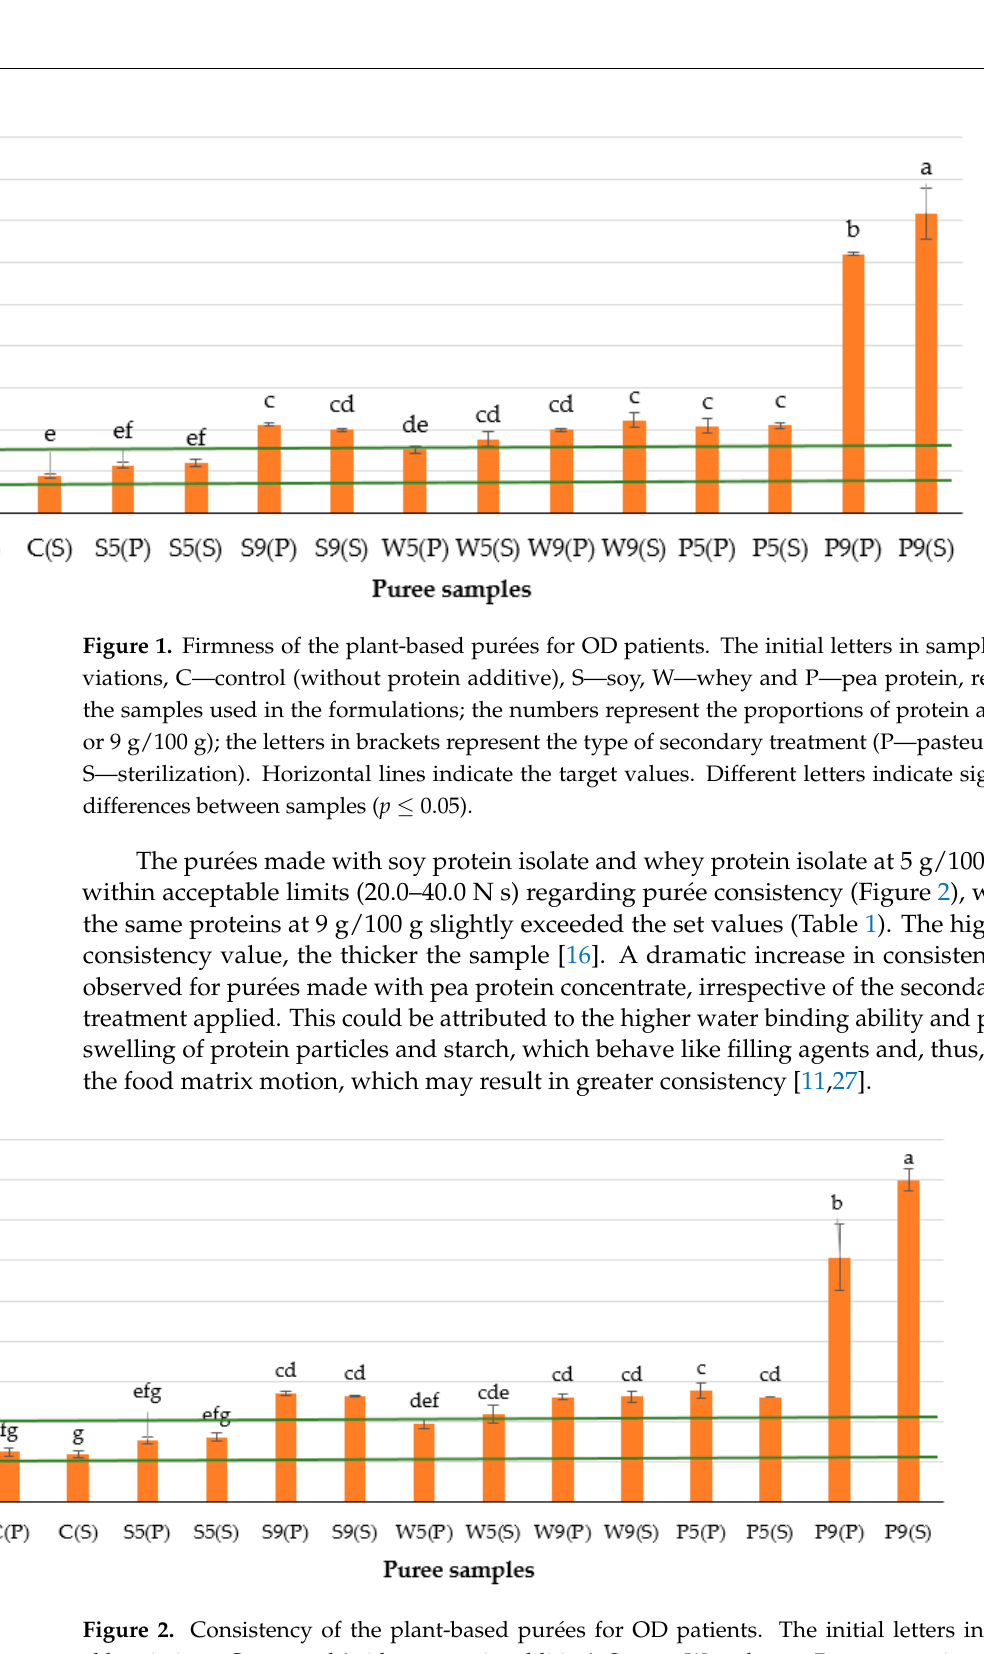
Figure 2. Consistency of the plant-based purées for OD patients. The initial letters in sample abbreviations, C—control (without protein additive), S—soy, W—whey or P—pea protein, represent the samples used in the formulations; the numbers represent the proportions of protein added (5 or 9 g/100 g); the letters in brackets represent the type of secondary treatment (P—pasteurization; S—sterilization). Horizontal lines indicate the target values. Different letters indicate significant differences between samples ( p ≤ 0.05).